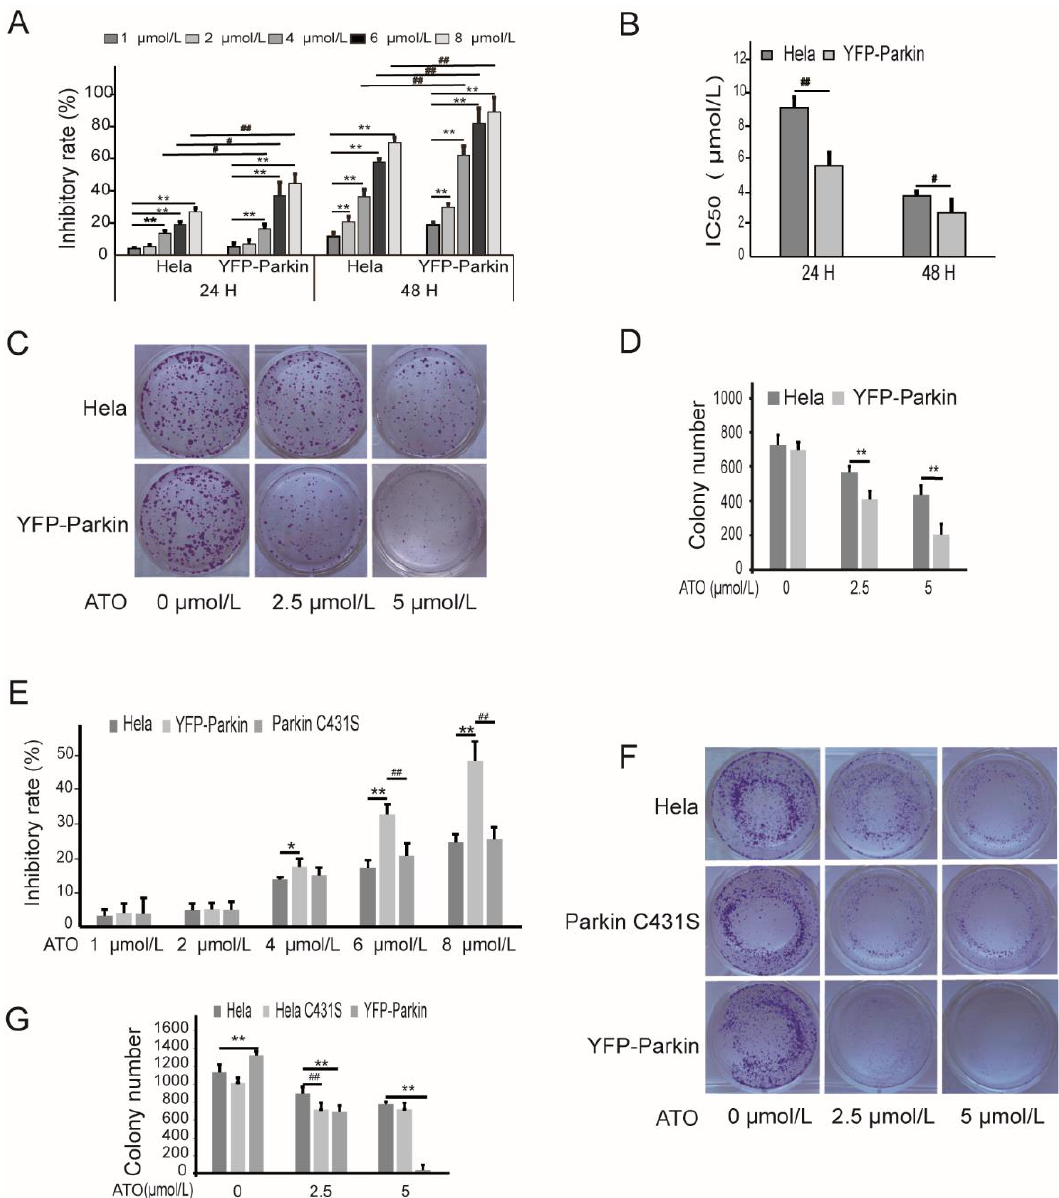
Figure 1. ATO modulates proliferation of HeLa cells. ( A ) MTT assays revealed that overexpression of YFP-Parkin significantly decreased the growth rate of the indicated cells. ( B ) The percentage of IC 50 . ( C ) YFP-Parkin decreased the mean colony number in the colony formation assay. ( D ) Quantification of C. ( E ) MTT assays revealed that Parkin C431S rescued the growth rate after ATO treatment for 24 h. ( F ) Parkin C431S rescued the mean colony number in the colony formation assay. ( G ) Quantification of F. The histograms represent the mean ± SD of triplicate experiments. * p < 0.05 vs. 0 µmol/L group, ** p < 0.01 vs. 0 µmol/L group; # p <0.05 vs. without Parkin group, ## p <0.01 vs. without Parkin group.